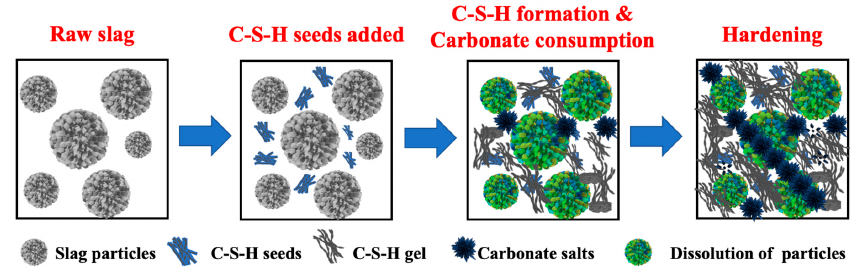
Figure 9. Proposed role of C-S-H seeds on the early age reaction of carbonate